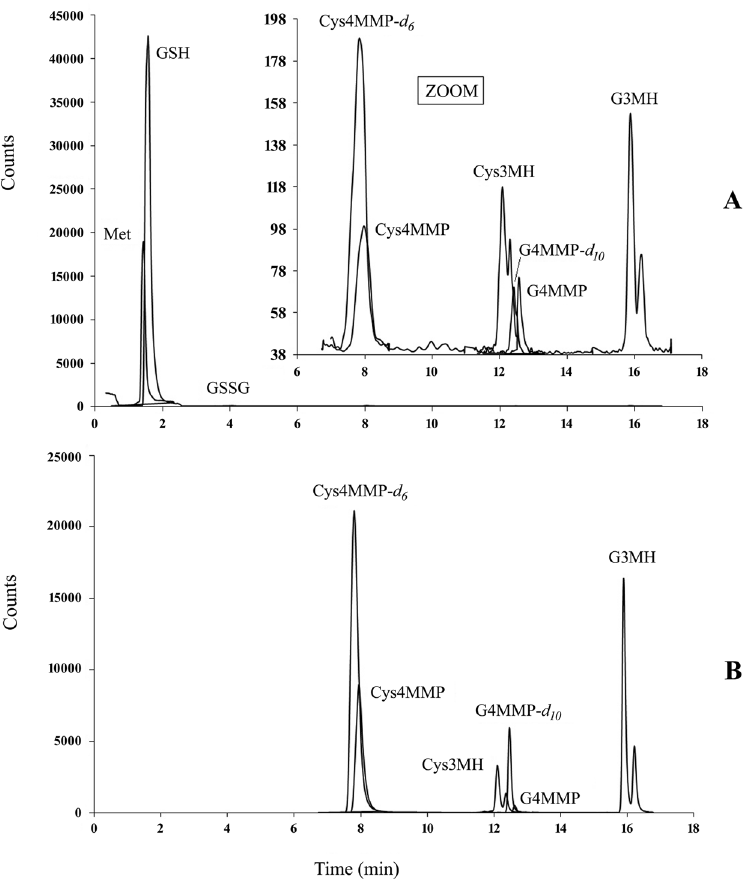
Figure 1. ESI + selected reaction monitoring (SRM) chromatogram of methionine, glutathione, oxidized glutathione, thiol precursors and deuterium labelled analogues of MMP conjugates in Sauvignon Blanc grape methanol extract – direct injection ( A) and ESI + SRM chromatogram of thiol precursors and deuterium labelled analogues of MMP conjugates in purified and concentrated Sauvignon Blanc grape extract ( B